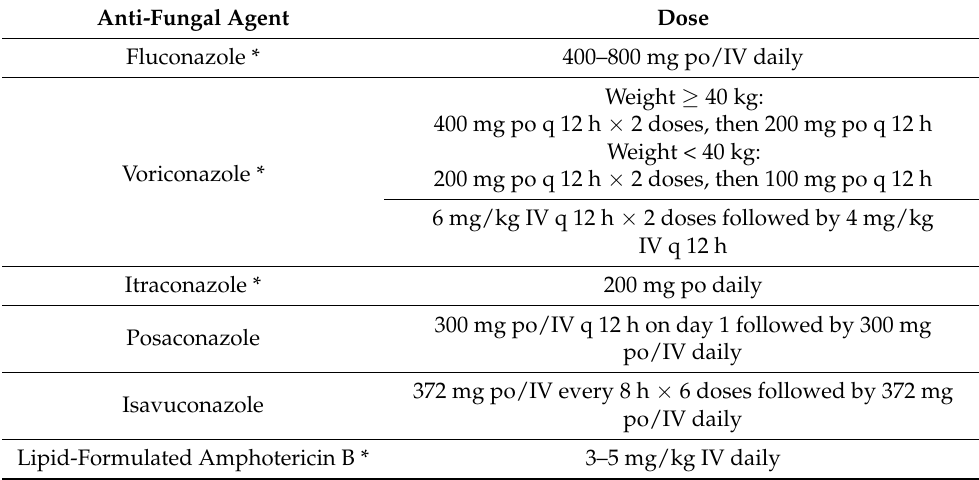
Table 2. Anti-coccidioidal